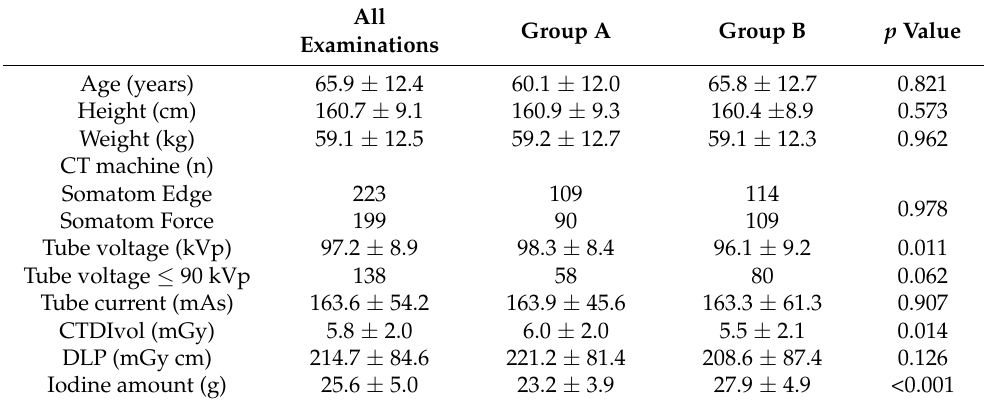
Table 1. Baseline characteristics of the